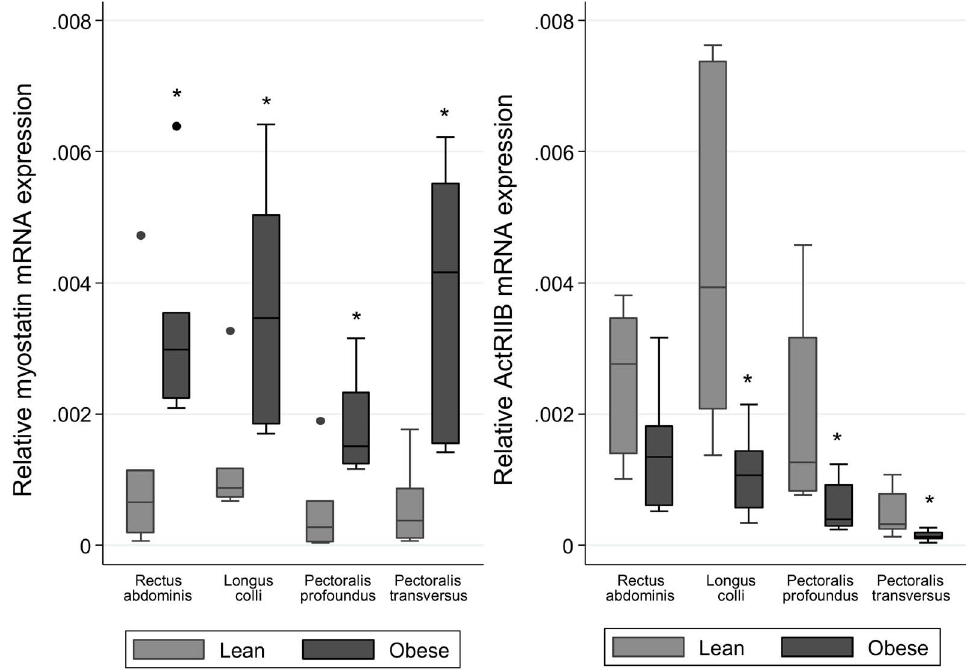
Figure 1. Gene expression of Myostatin and ActRIIB in skeletal muscles of lean and obese horses and ponies. Gene expression was analysed by real-time PCR and the geometric mean of the two most stable housekeeping genes as determined by GeNorm (GAPDH and beta-actin) was used for normalisation. Relative transcript abundance is shown for Myostatin (A) and ActRIIB (B). *denotes where values differ significantly (p , 0.05) from lean group. n=6/group.